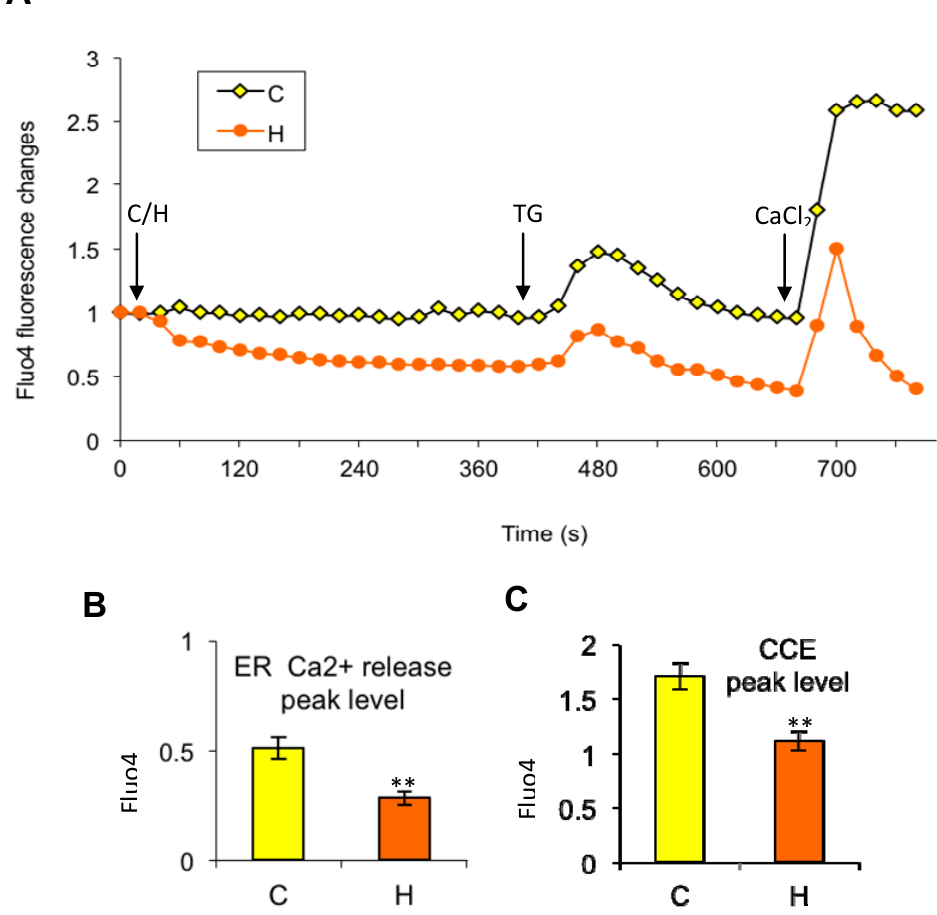
Figure 6. Effects of high dose paclitaxel (H) on the cytosolic Ca 2+ levels in a Ca 2+ -free medium. ( A ) Time-response curves (mean) were determined from data generated in three independent tests. Before analyzing, cells were transferred to a Ca 2+ -free medium. Then high dose paclitaxel at 10 − 6 M was added (H) or not (C) into the medium, indicated by the first arrow. After waiting until fluo-4 levels stabilized (~5 min), TG (3 μ M) and CaCl (2 mM) were added respectively, indicated by subsequent, labeled arrows. For the curves; ( B ) peak levels of endoplasmic reticulum (ER) Ca 2+ release and ( C ) subsequent CCE were compared for control and high dose paclitaxel treated groups, which were represented by mean ± SD. ** indicates significance at p <